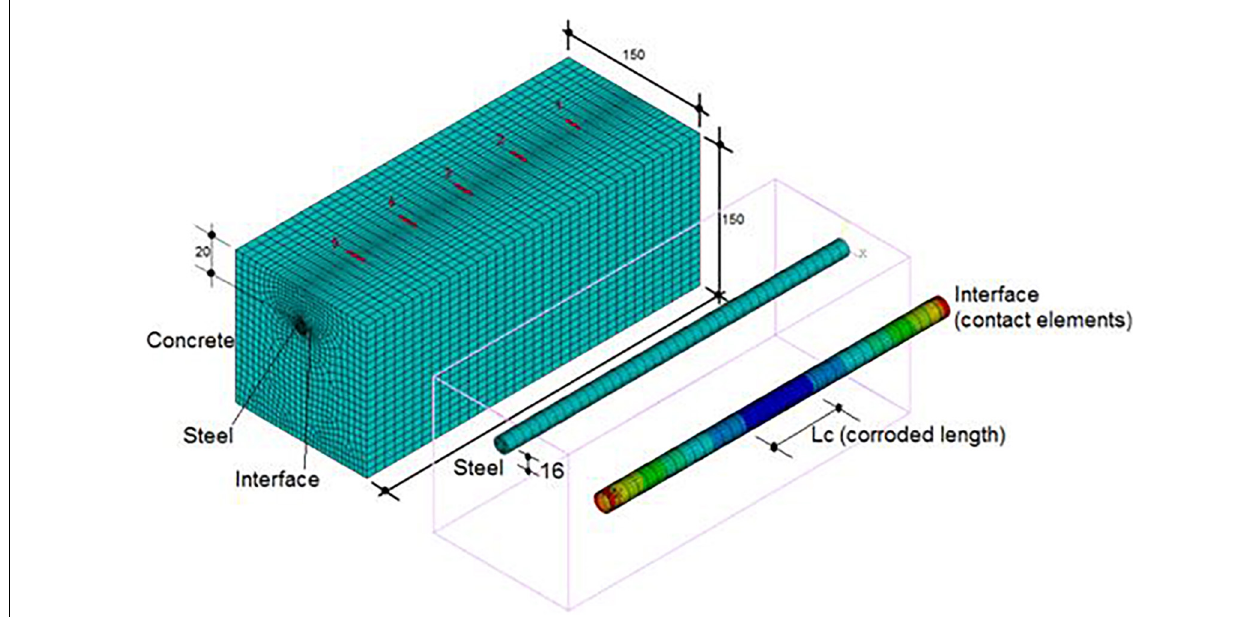
FIGURE 1 | Physical model used to perform numerical analysis by FEM.